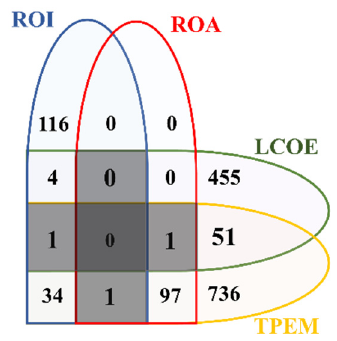
Figure 2. Intersections of articles in different